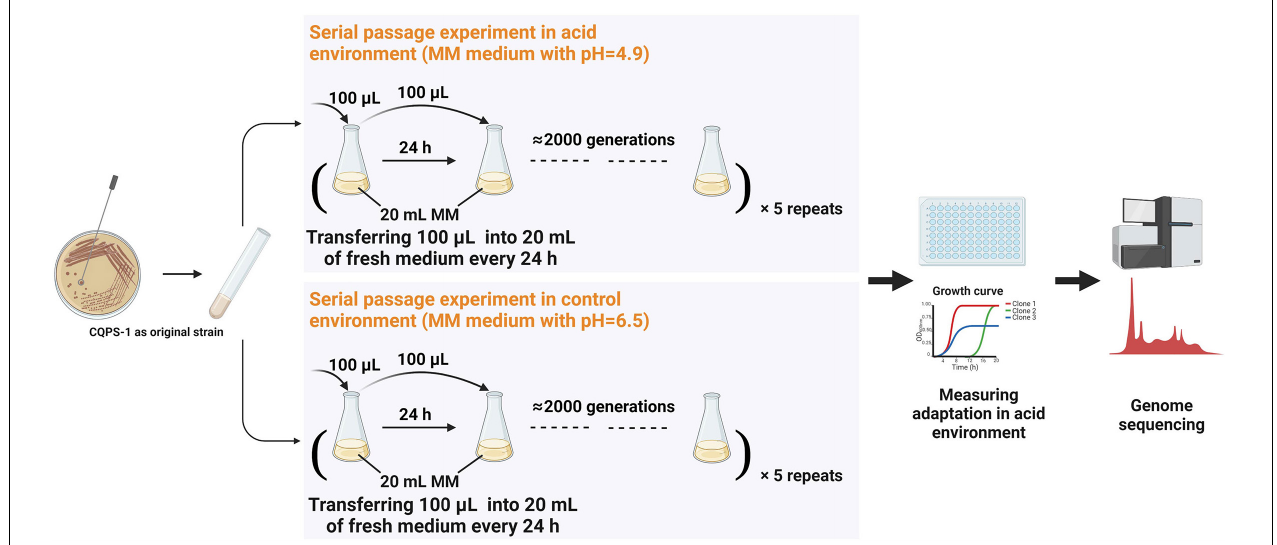
FIGURE 1 | Long-term experimental evolution of CQPS-1 in an acidic environment. MM medium at pH 4.9 was used as the acidic environment, and MM medium (pH 6.5) was used as the control. Cultures were propagated daily by transferring 100 µ L of each culture into 20 mL of fresh medium. The figure was created with